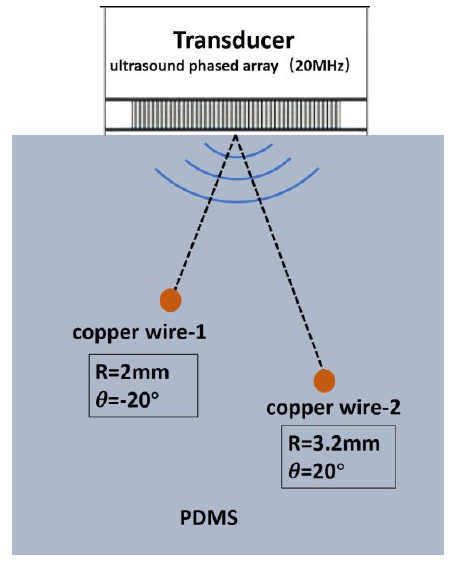
Figure 11. Schematic diagram of copper wire phantom in PDMS.